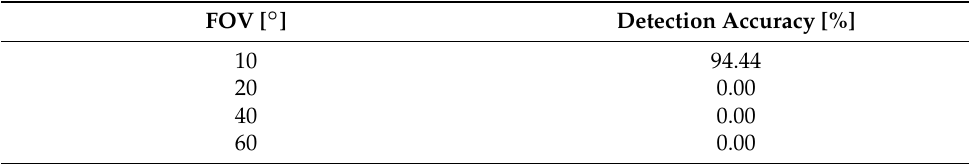
Table 6. Frequency estimation accuracy as a function of the FOV. Transmitter–receiver distance is kept fixed at 5 m.